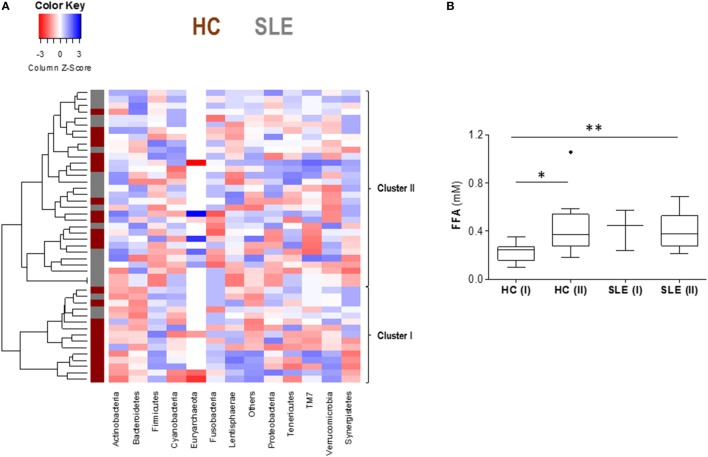
Cluster analysis revealed a link between gut microbiota composition and total free fatty acids (FFA) serum levels. (A) Heatmap plotting gut microbiota composition, based on the main phyla, in healthy controls (HC) and systemic lupus erythematosus (SLE) patients. Tiles are colored based on the abundance of each group, red and blue colors indicating low or high levels, respectively. Each row represents an individual, and the vertical colored bar at the left represents HC (dark red) or SLE patient (gray). Two clusters were identified and are highlighted at the right (clusters I and II). (B) Comparison of total FFA serum levels among groups after stratifying by disease status (HC or SLE) and microbiota clusters (I or II). Boxes represent median and interquartile range, whereas whiskers represent minimum and maximum values. Differences were assessed by Kruskal–Wallis test and Dunn–Bonferroni post hoc correction for multiple comparisons tests. *p < 0.050, **p < 0.010.